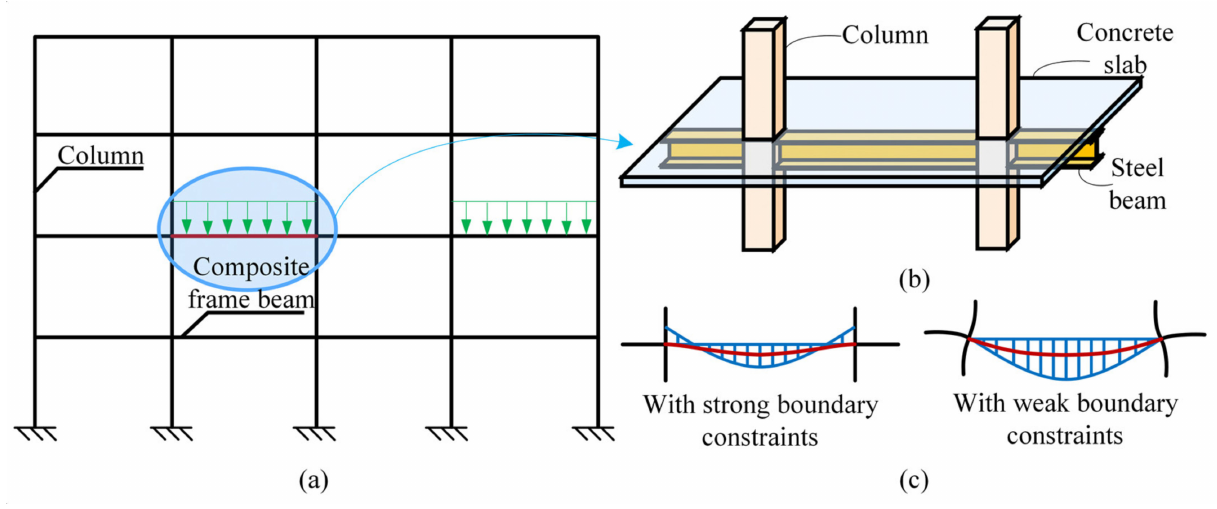
Figure 1. Bending mechanism of the composite frame beam in a structural system. (( a ) Composite frame structural system; ( b ) Composite frame beam; ( c ) Deformation and bending moment diagram of composite frame